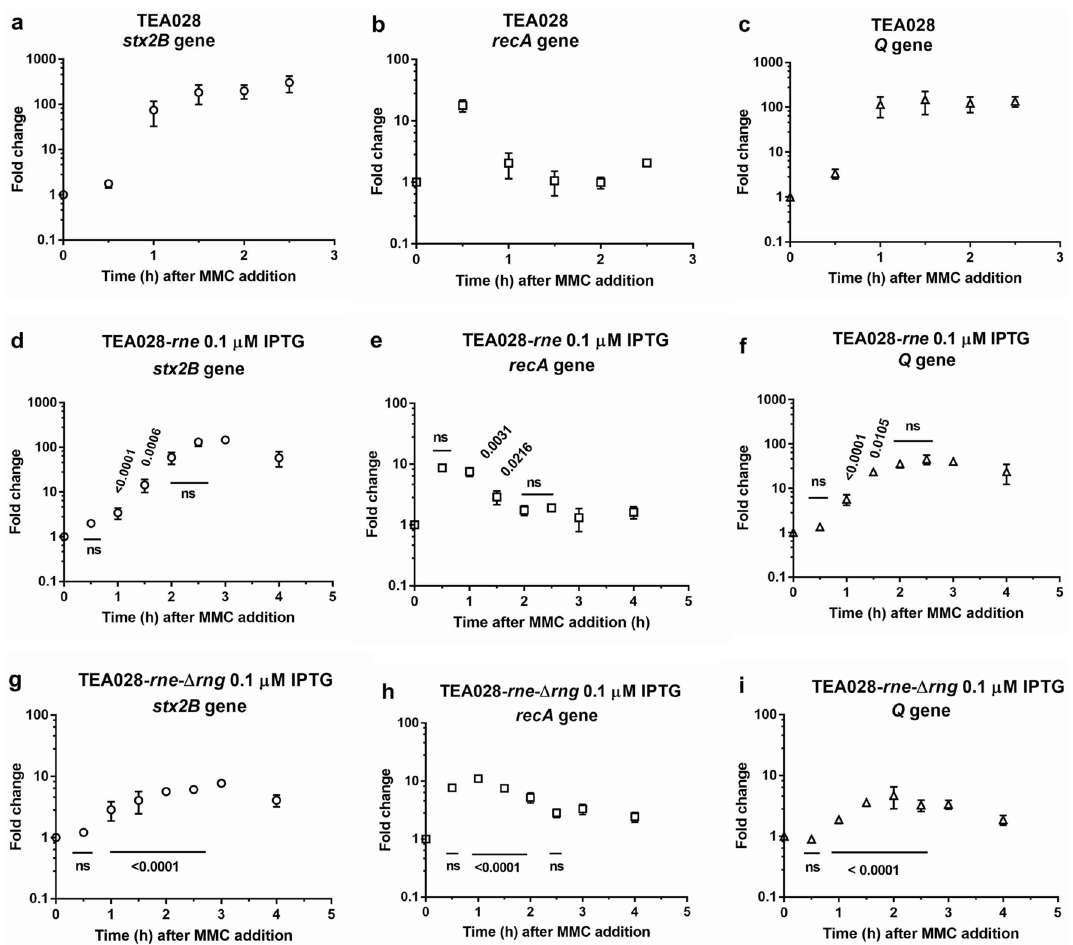
Figure 4. Kinetics of mRNA concentrations of stx2B , recA , and Q genes in EHEC TEA028 and its RNases E and G derivatives. Cultures of TEA028 (parental strain) and its RNase E/G derivatives were grown in Luria Bertani medium to an optical density at 600 nm of 0.30–0.35 (time 0) at which point the cultures were treated with MMC (1 µg/mL) to induce the phage lytic cycle and toxin production. Thereafter, samples were collected at the indicated time intervals for total RNA extraction and reverse transcription real-time PCR. The strains TEA028- rne and TEA028- rne -Δ rng underproduce RNase E when the medium is supplemented with 0.1 µM IPTG. The concentration of cDNA molecules for each gene was normalized to the concentration of cDNA molecules of 16S rRNA. Fold change was calculated as the ratio of the normalized cDNA molecules at the indicated time points after MMC addition to the normalized cDNA molecules before the addition of MMC (time 0). Adjusted P values versus TEA028 (control) are indicated in each graph, ns not significant. Means and standard errors of 3–4 biological replicates are shown. ( a ) TEA028, stx2B gene. ( b ) TEA028, recA gene. ( c ) TEA028, Q gene. ( d ) TEA028- rne 0.1 µM IPTG, stx2B gene. ( e ) TEA028- rne 0.1 µM IPTG, recA gene ( f ) TEA028- rne 0.1 µM IPTG, Q gene. ( g ) TEA028- rne -Δ rng 0.1 µM IPTG, stx2B gene. ( h ) TEA028- rne -Δ rng 0.1 µM IPTG, recA gene. ( i ) TEA028- rne -Δ rng 0.1 µM IPTG, Q